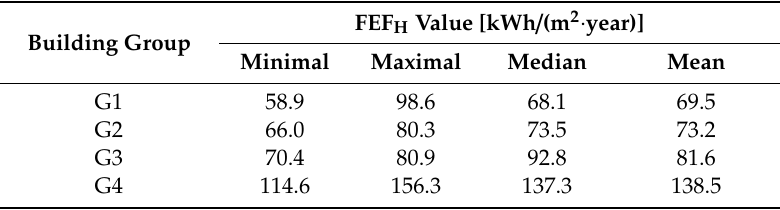
Table 8. Values of the FEF H factor after thermal retrofitting.